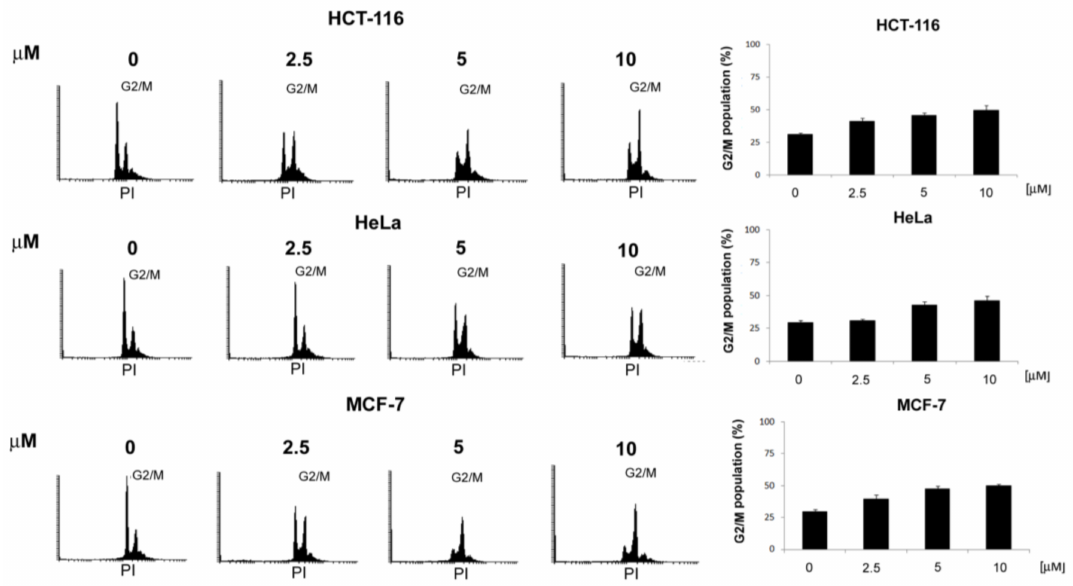
Figure 10. Effects of 28 on G2/M arrest in HCT-116, HeLa, and MCF-7 cells. Cells were treated with the indicated concentrations of 28 for 48 h (HCT-116) and 72 h (HeLa and MCF-7), and cell cycle distribution was analyzed using flow cytometry. Values represent mean ± SD of three independent